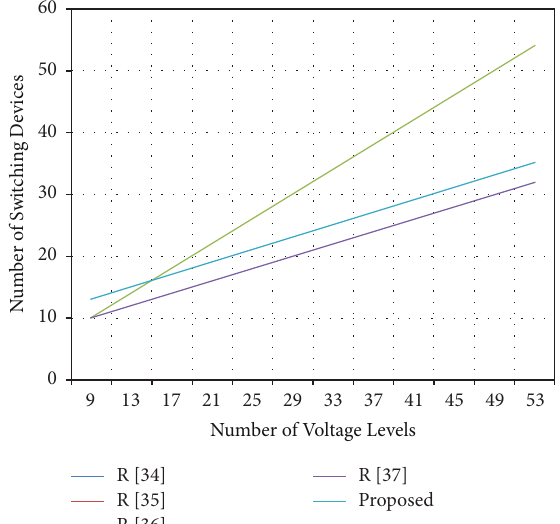
Figure 11: No. of voltage levels vs no. of switching